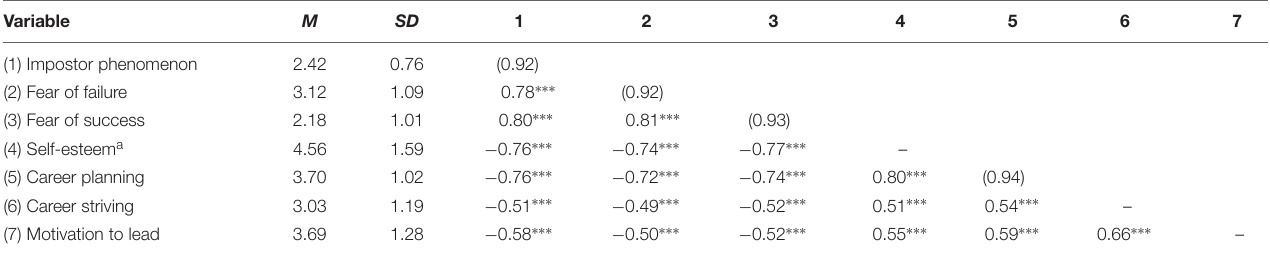
TABLE 3 | Means, standard deviations, and correlations for the main variables in Study 2. Variable